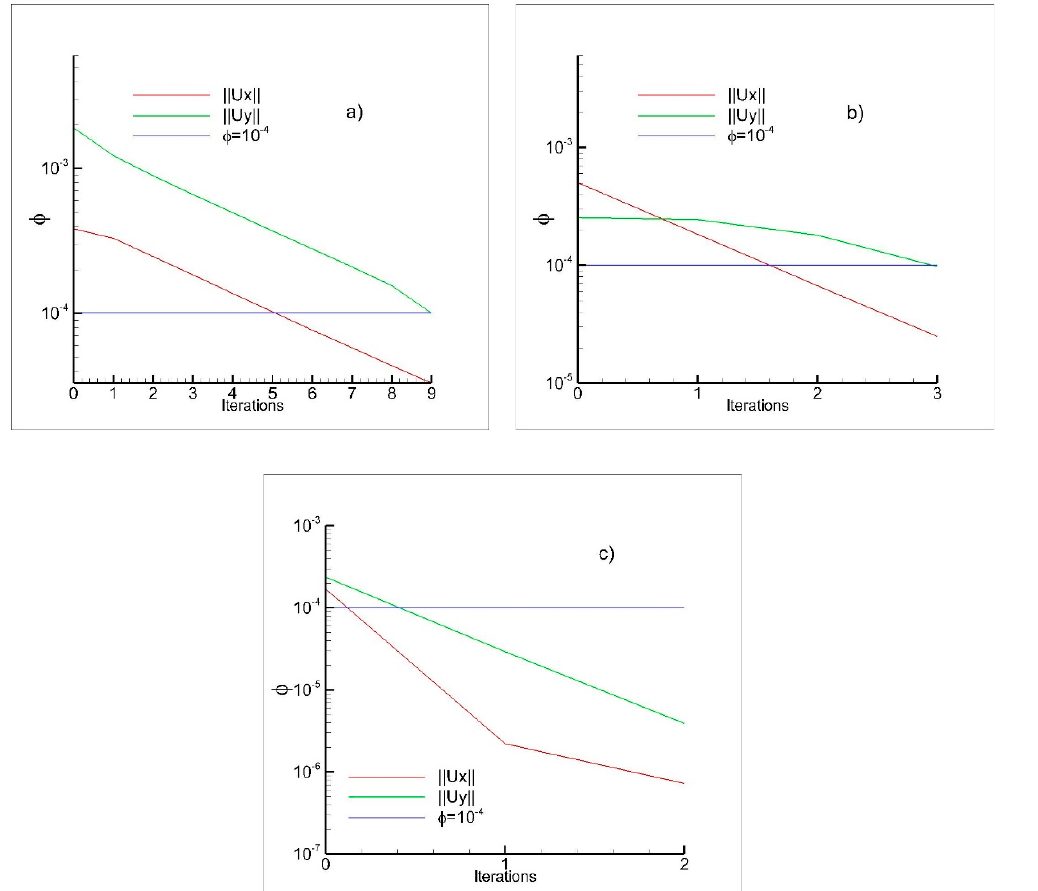
Figure 11. Convergence history— φ values for: ( a ) Local Model 1, ( b ) Local Model 2, ( c ) Local Model 3.